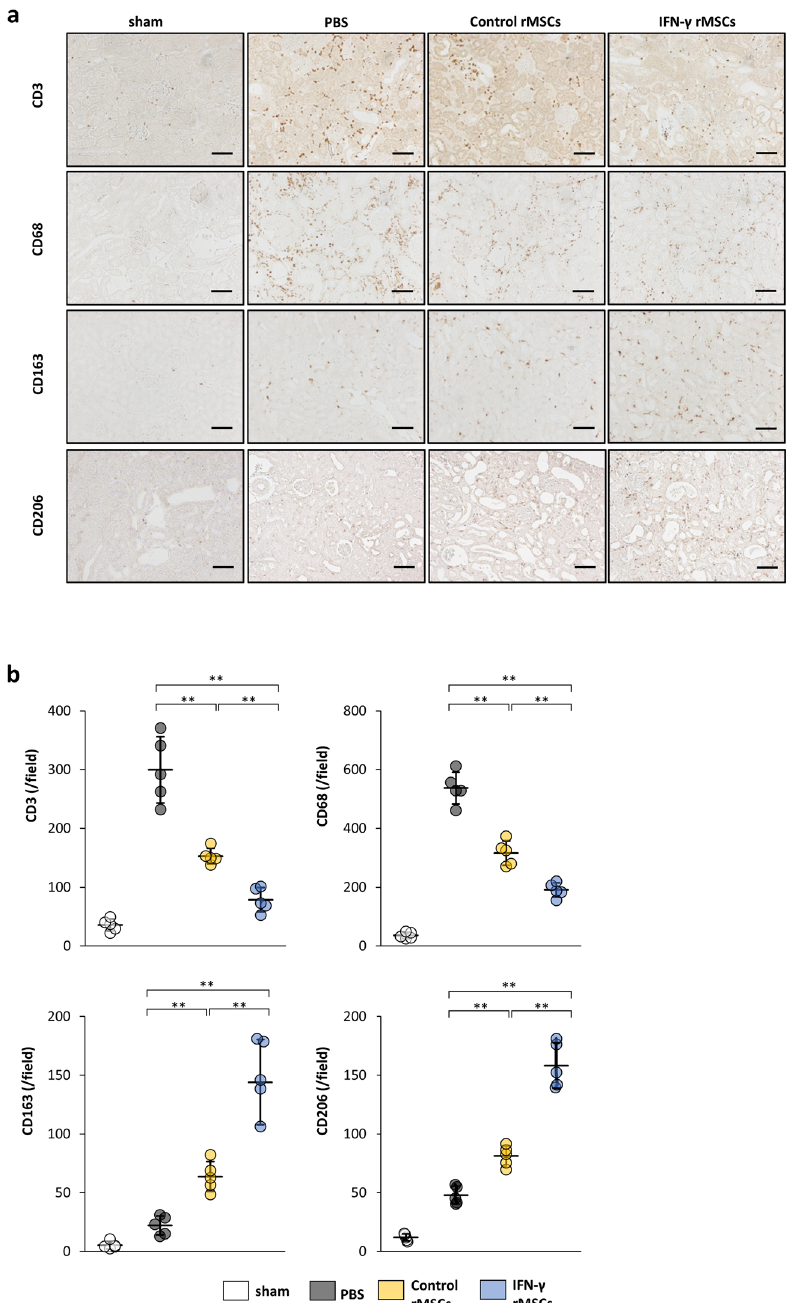
Figure 3. Anti-inflammatory effects of IFN-γ-treated MSCs in IRI rats. Infiltration of T cells and macrophages into injured kidney of MSC-injected IRI rats was assessed at 7 days after IRI by immunostaining. ( a ) Representative immunohistochemical staining of CD3, CD68, CD163 and CD206 in rat kidney sections (scale bar, 100 µm). ( b ) Quantification of CD3-, CD68-, CD163- and CD206-positive cells (n = 5 in each group). Data are presented as the mean ± SD. ** p < 0.01. Abbreviations are as in Fig.